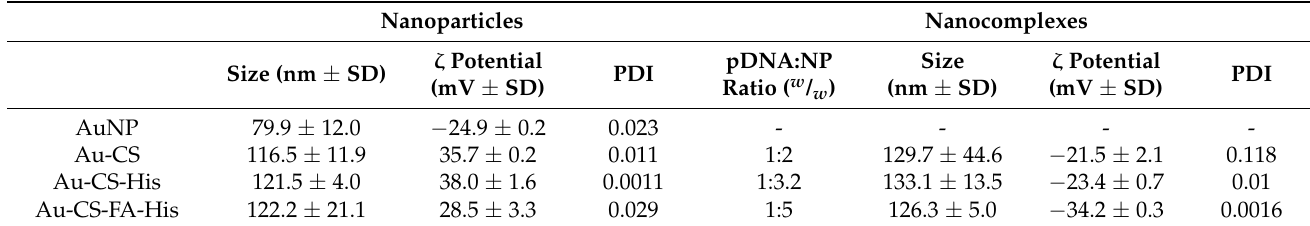
Figure 3. HRTEM images of ( A ) AuNPs, ( B ) Au-CS, ( C ) Au-CS-His and ( D ) Au-CS-FA-His. Scale bar = 100 nm. Table 2. Hydrodynamic size, zeta ( ζ ) potential and polydispersity index (PDI) values of AuNPs, FAuNPs and their respective nanocomplexes with